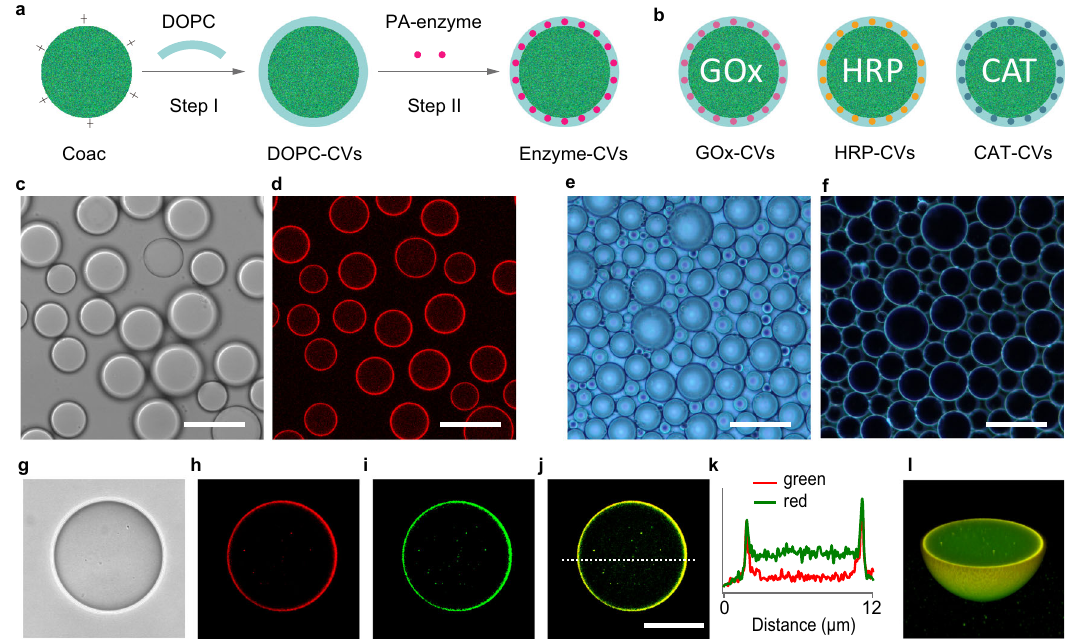
Fig. 1 | Assembly and characterization of enzyme-decorated coacervate vesi- cles. a Scheme showing design and construction of enzyme-decorated coacervate vesicles. Step I: a suspension of positively charged PDDA/DNA coacervate (Coac) micro-droplets is added to a DOPC/ethanol solution to produce phospholipid- based coacervate vesicles (DOPC-CVs). Step II: The DOPC-CVs are surface- decorated with palmitic acid-modi fi ed enzymes (PA-enzyme) to give molecularly crowded protocells with reactive outer membranes (Enzyme-CVs). b Types of enzyme-decorated coacervate vesicles produced; PA-glucose oxidase (GOx-CVs), PA-horseradish peroxidase (HRP-CVs) and PA-catalase (CAT-CVs). Labels marked insidetheCVs(GOx,HRPandCAT)identifythedifferenttypesofCVs;ineachcase, thePA-enzymesareattachedtotheoutermembranesurfaceandnotencapsulated. Bright fi eld ( c ) and corresponding red fl uorescence ( d ) images of undecorated DOPC-CVs (PDDA: DNA=0.6: 1, w/w; DOPC: coacervate = 0.1: 1, w/w) stained with